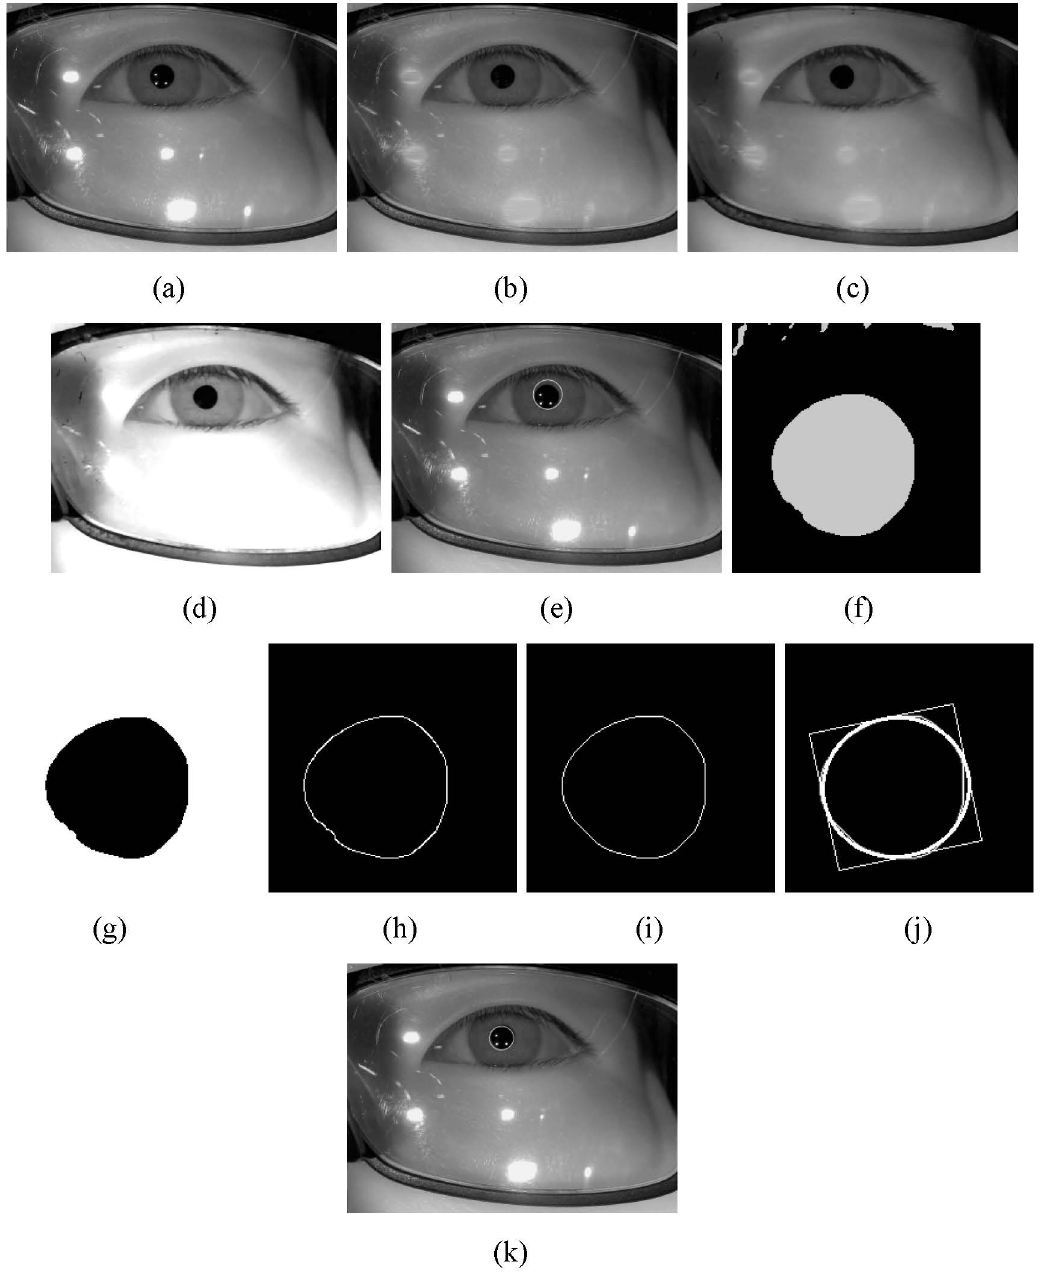
Figure 8. Examples from the pupil detection process. ( a ) Original image; ( b ) After erasure of the SR regions; ( c ) Image resulting from morphological operations; ( d ) Image resulting from histogram stretching; ( e ) Pupil area that is detected by the CED method; ( f ) Binarized image of the predetermined area (based on the detected pupil region) from ( d ); ( g ) Image resulting from morphological erosion and dilation of ( f ); ( h ) Result from component labeling and canny edge detection; ( i ) Result from the convex hull method; ( j ) Result from ellipse fitting; ( k ) Result of the pupil detection